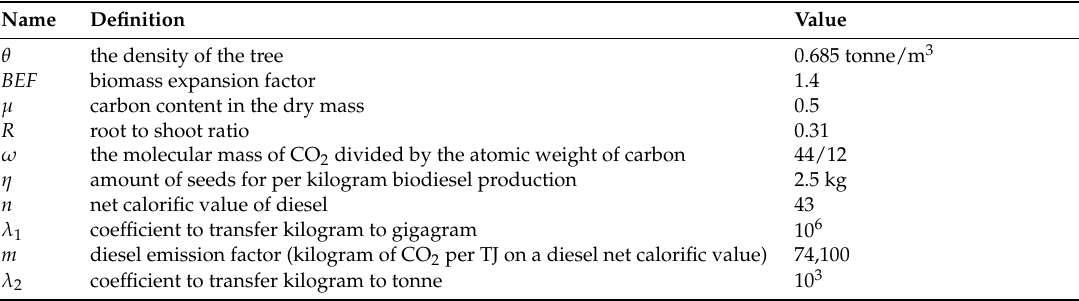
Table A1. The coefficients and their values in this paper.